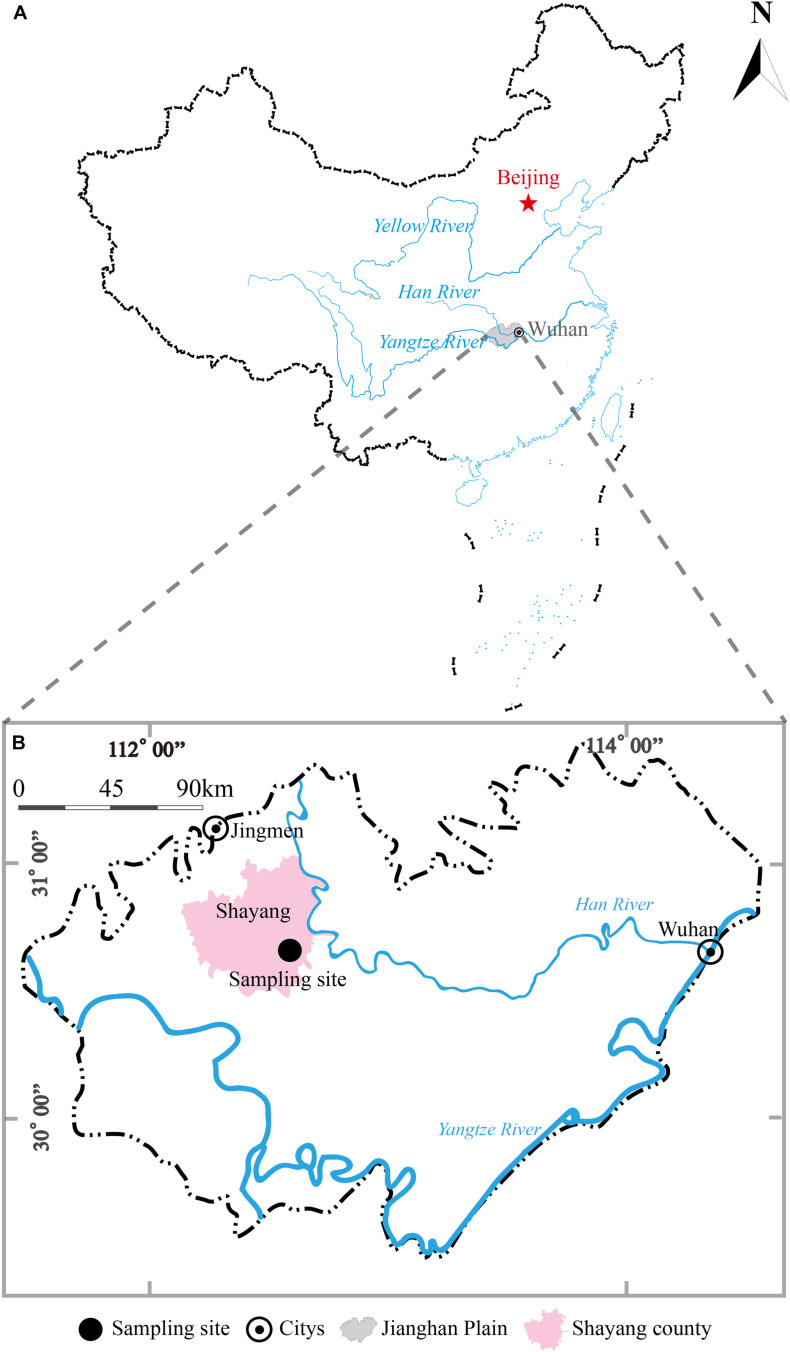
A geographic map showing locations of Jianghan Plain, China (A) and borehole site for clay sediment sampling in Jianghan Plain (B). The shadow area in map (A) refers to the boundary of Jianghan Plain.